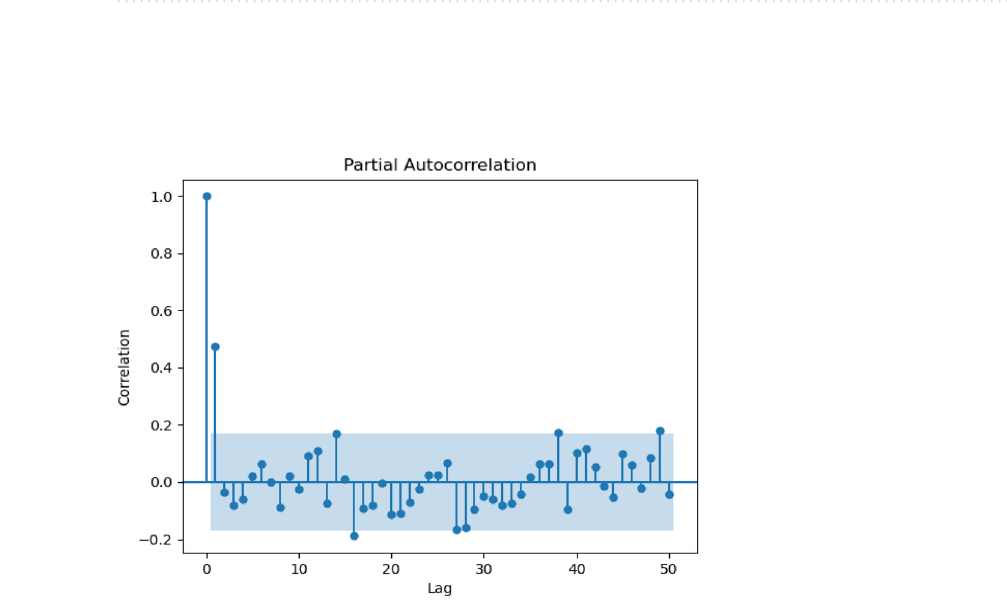
Figure 8. Partial autocorrelation for the monthly